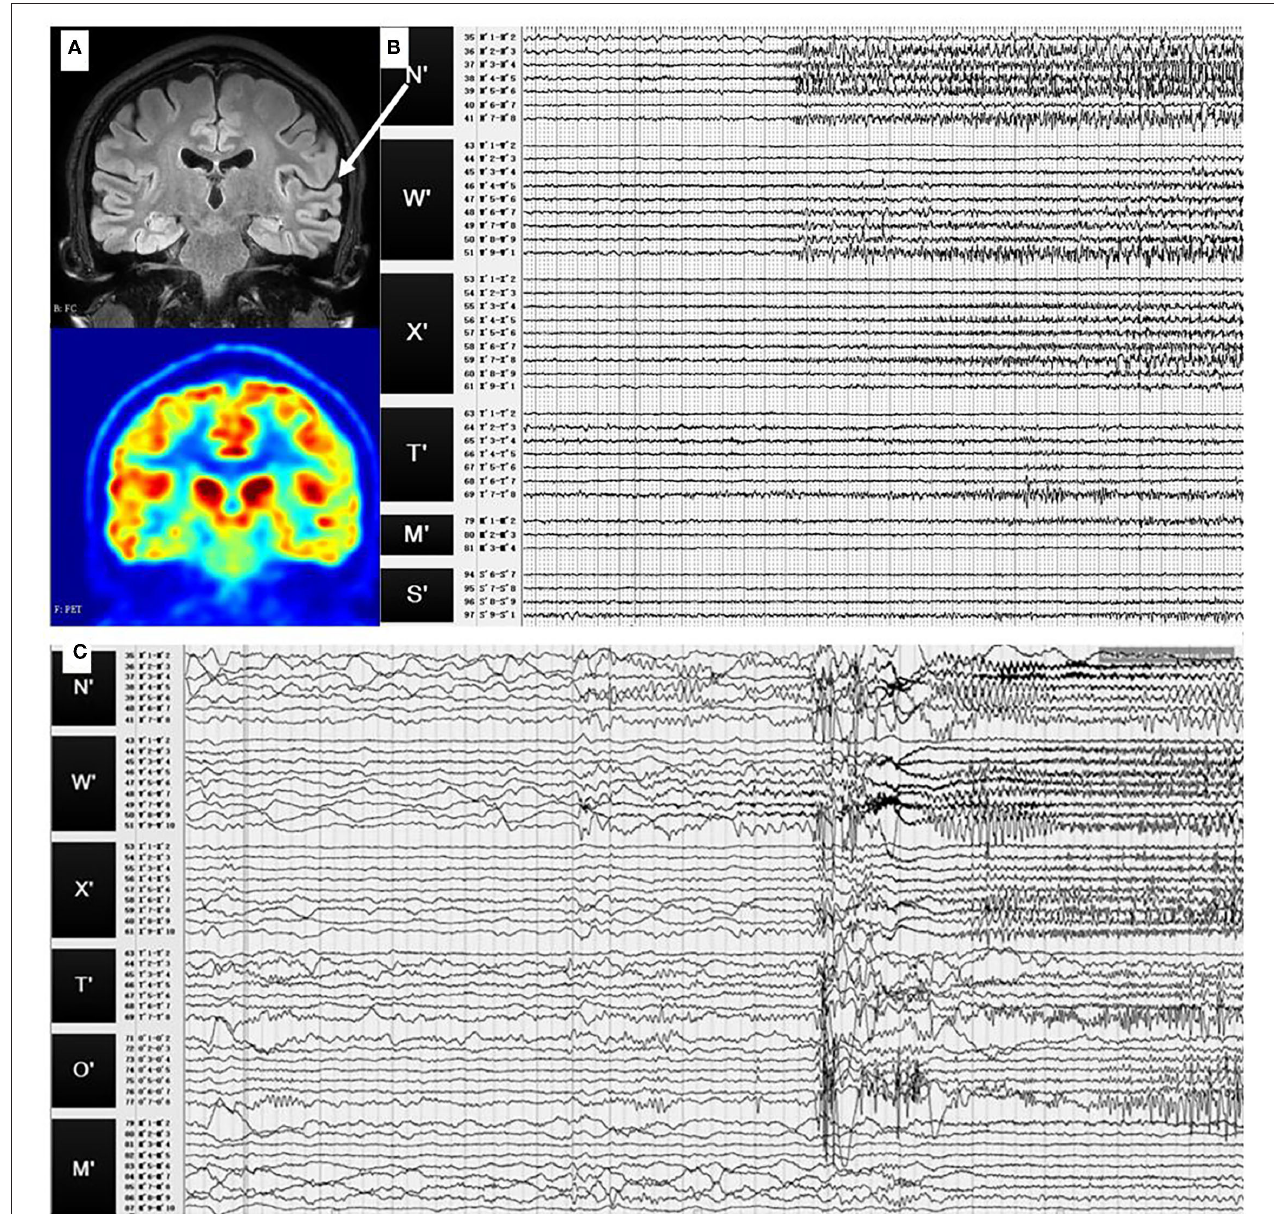
FIGURE 4 | (A) Preoperative T1-weighted MRI and PET results of case 2. No abnormality was found in MRI, while hypometabolism was identified in the left superior temporal gyrus. (B) SEEG signals of the first seizure pattern. During this pattern, fast activities or sharp slow waves were identified at the left superior temporal gyrus (N ′ 3-5), then sharp waves and spike waves spread in the left superior temporal gyrus (N ′ 2-8, W ′ 5-10, X ′ 4-8). (C) SEEG signals of the second seizure pattern. There were fast activities and slow-wave oscillation at the left superior temporal gyrus (N ′ 3-5), then the fast activities spread in the left superior temporal gyrus (W ′ 2-9, N ′ 2-6), and finally, spread to the other sites. White arrow: the location of the electrodes N ′ in MRI (left superior temporal